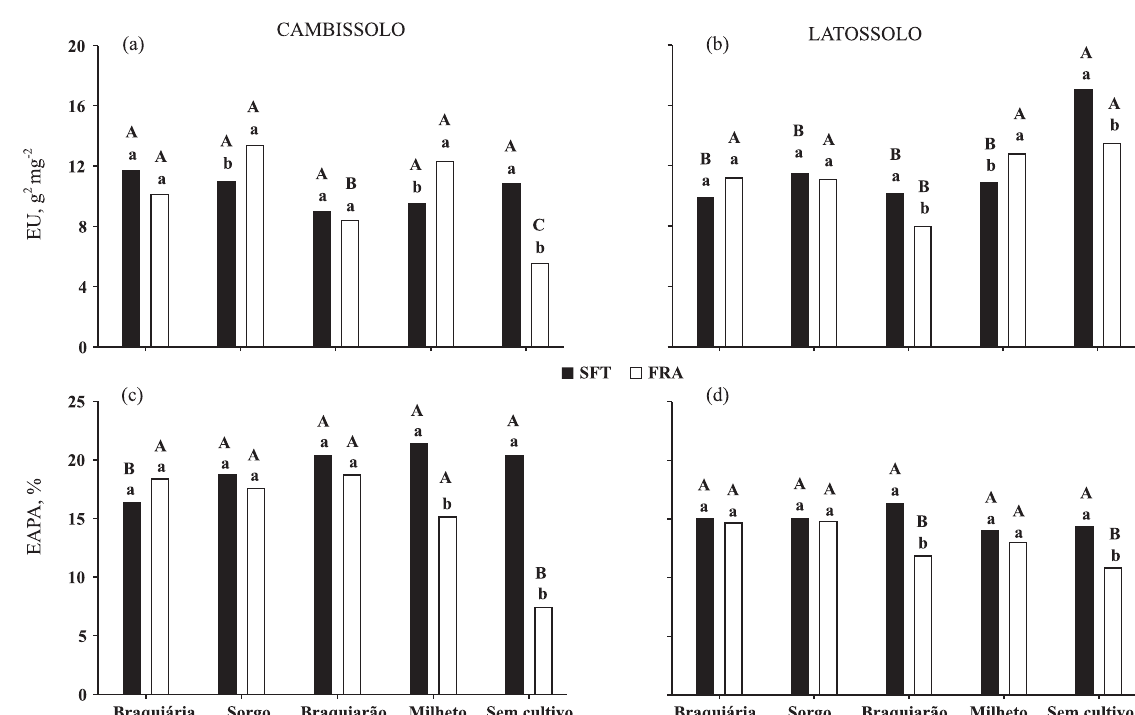
Figura 2. Eficiência de utilização (EU) (a e b) e eficiência de aproveitamento do P aplicado (EAPA) (c e d) do feijoeiro cultivado em sucessão a gramíneas forrageiras e em solo sem cultivo, adubados com superfosfato triplo (SFT) e fosfato reativo de Arad (FRA) no Cambissolo e Latossolo. Em cada solo, médias seguidas de mesma letra minúscula, comparando as fontes de P para cada gramínea forrageira e solo sem cultivo, e maiúscula, comparando as gramíneas forrageiras e solo sem cultivo em cada fonte de P, não diferem entre si (Scott Knott, p ≤ ≤ ≤ ≤ ≤